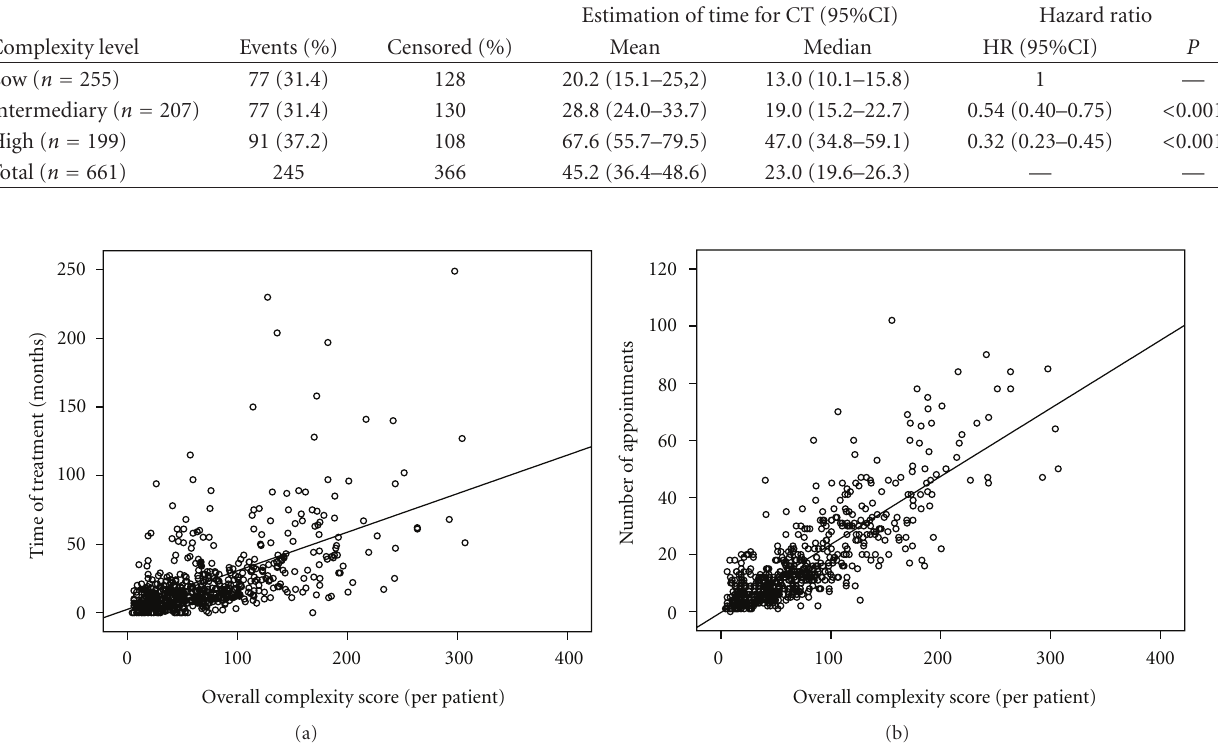
Figure 2: Scatterplots of the association between complexity scores and time of treatment and number of appointments.